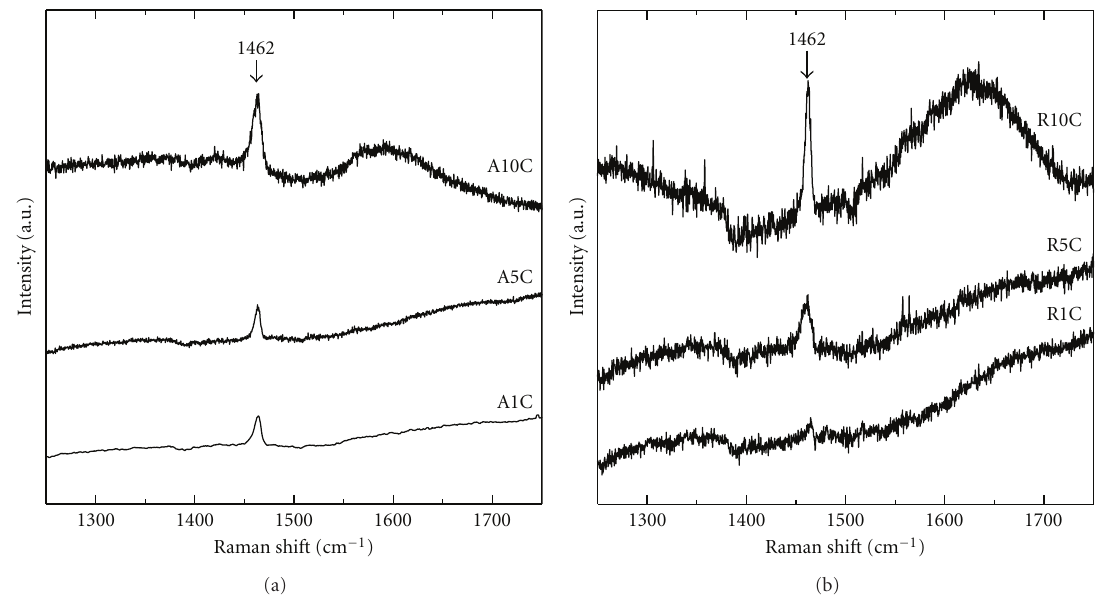
Figure 4: Raman spectra of the TiO 2 − C 60 composite samples. (a) The A1C, A5C, and A10C samples, (b) the R1C, R5C, and R10C samples.